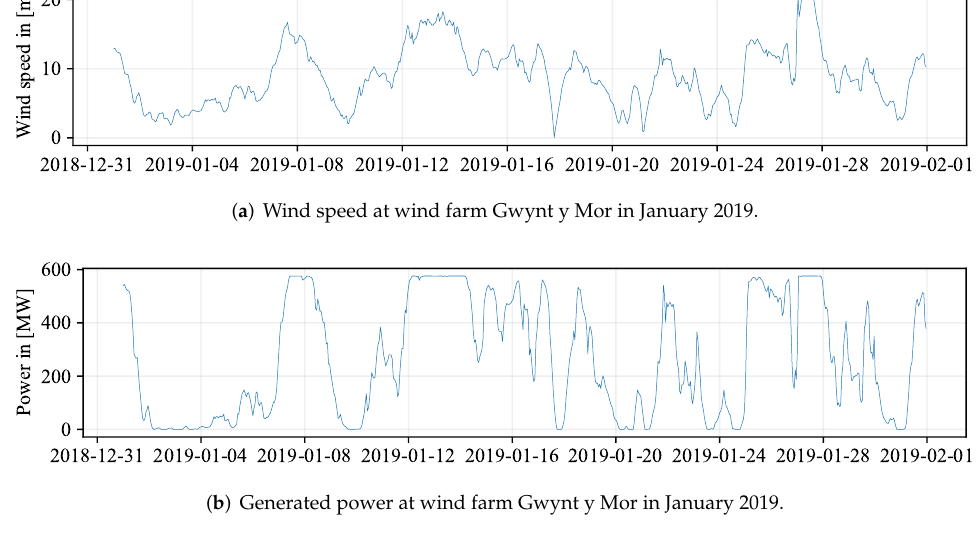
Figure 5. Wind speed and power for Gwynt y Mor from 1 January 2019 to 31 January